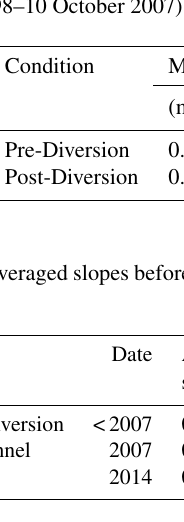
Figure 7. Median of the LOWESS model residuals grouped by (a) individual storm event and; (b) season, and the rainfall erosivity index grouped by (c) individual storm event and (d) season. The colours represent the different seasons with brown representing autumn; blue – winter; green – spring and; yellow – summer. Table 4. Summary statistics calculated from river level data collected at Lealholm monitoring station (NZ7627207611) based on observations at 15min intervals. Statistics provided include the mean, median and maximum river levels and the probability that the river level exceeds the long term (1998–2014) median (M), median · 5 (M5), and median · 10 (M10) threshold values. This is calculated for both pre-diversion